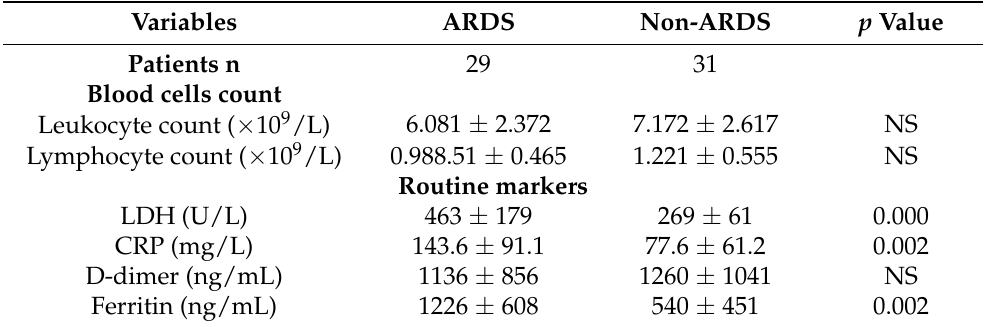
Table 2. Values of variables on hospital admission.